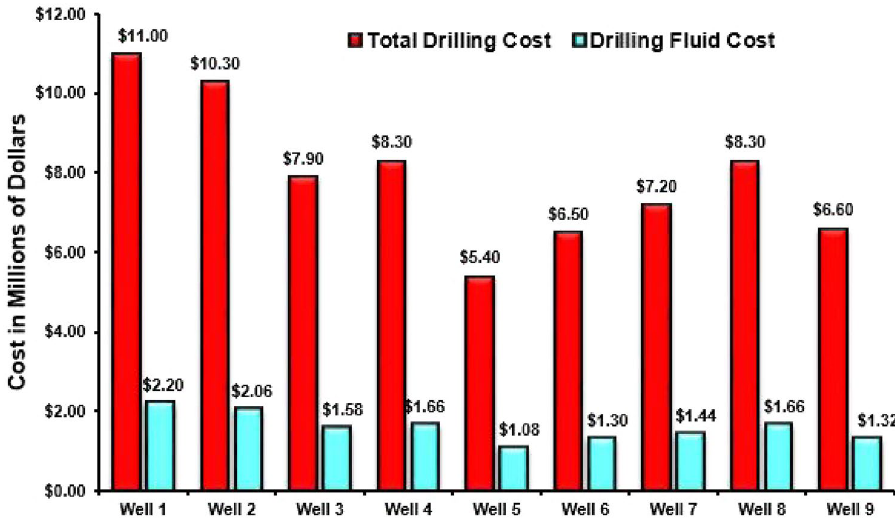
Fig. 4 Total cost of the